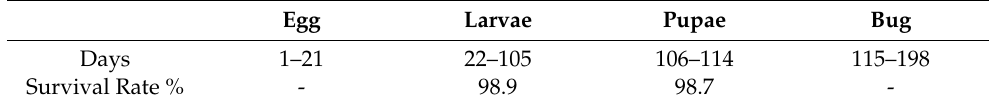
Table 1. The duration of mealworm development during the experiment. Egg Larvae Pupae Bug Days 1–21 22–105 106–114 115–198 Survival Rate % - 98.9 98.7 -